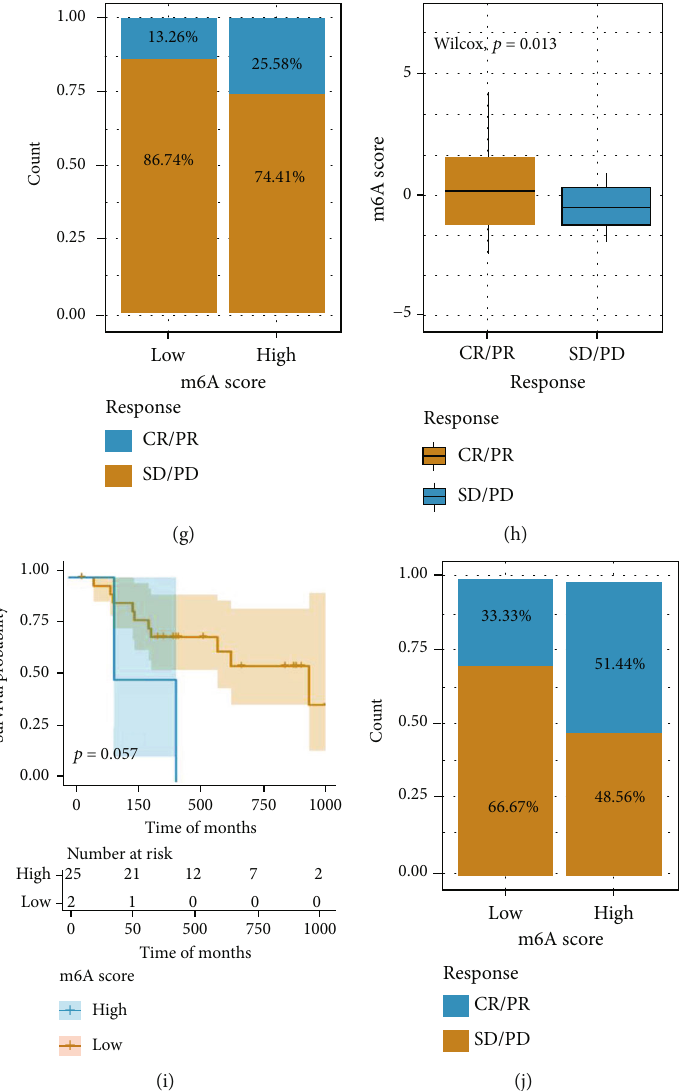
Figure 8: Evaluation of the performance of m6Ascore for predicting the clinical bene fi t of immunotherapy in patients with CRC. (a – d) Boxplot depicting di ff erences in the four immunophenoscores between high- and low-m6Ascore subgroups. (e) Di ff erences in m6Ascore among di ff erent clinical response subgroups in the IMvigor210 cohort. (f) OS curves between high- and low-m6Ascore subgroups in the IMvigor210 cohort. (g) Di ff erences in clinical responses between high- and low-m6Ascore subgroups in the IMvigor210 cohort. (h) Di ff erences in m6Ascore among di ff erent clinical response subgroups in the GSE78220 cohort. (i) OS curves between high- and low- m6Ascore subgroups in the GSE78220 cohort. (j) Di ff erences in clinical responses between high- and low-m6Ascore subgroups in the GSE78220